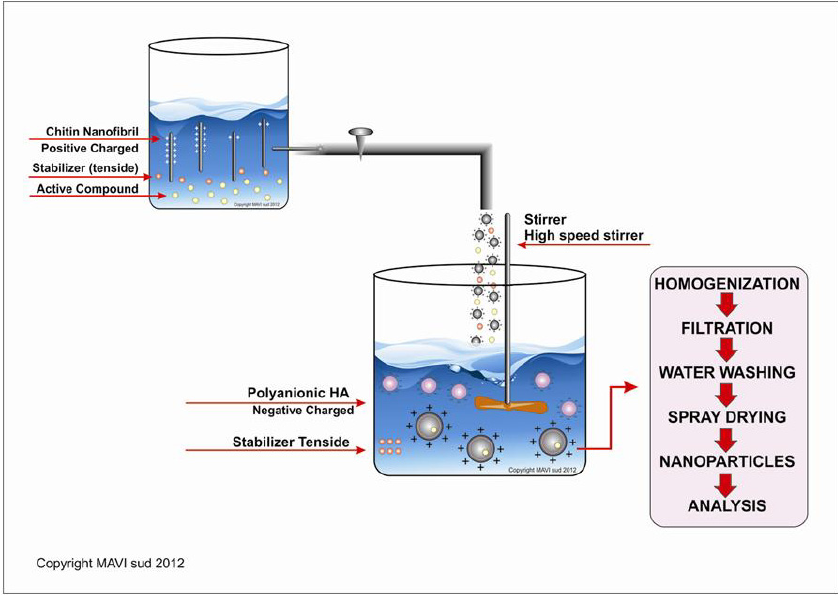
Figure 1. The gelation method between Chitin nanofibrils (CN) and Hyaluronan (HA)